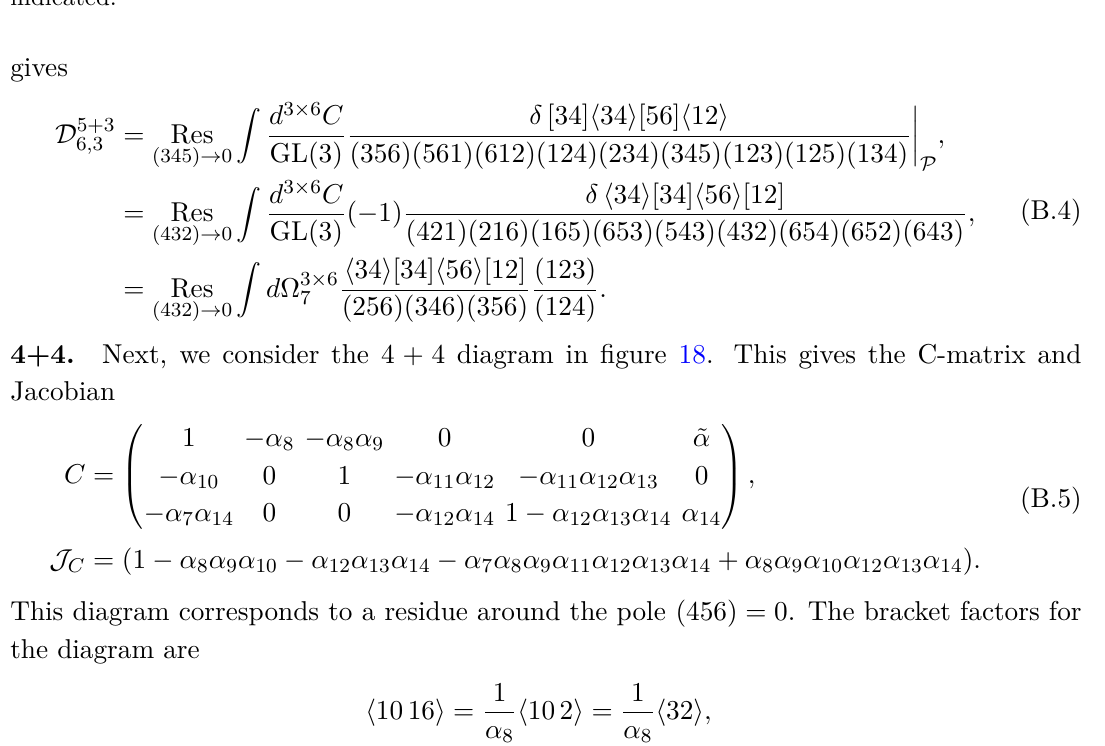
Figure 18 . ‘4+4’ on-shell diagram to be summed over 2 ↔ 4 and 3 ↔ 5 . Edge variables are